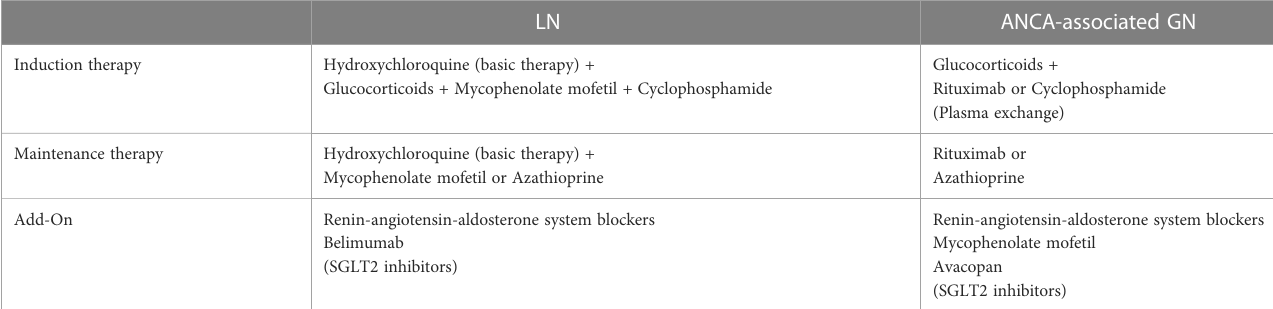
TABLE 1 Simpli fi ed treatment strategies in LN and ANCA-associated GN (esp. active, severe GPA/MPA) (62, 63).